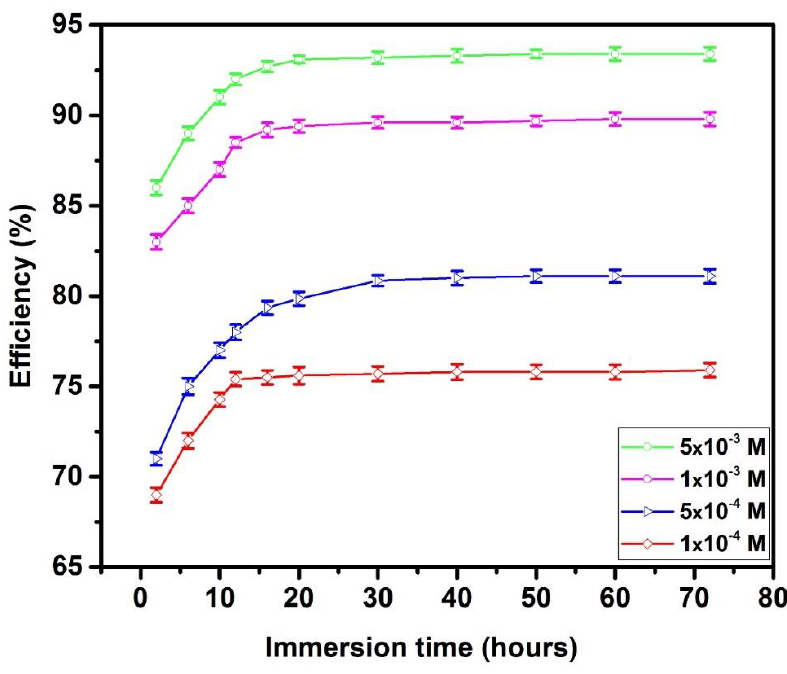
Figure 1. The inhibition efficiencies obtained for mild steel (MS) in 1.0 M HCl with the addition of various concentrations of 3-BIT at 303 K.